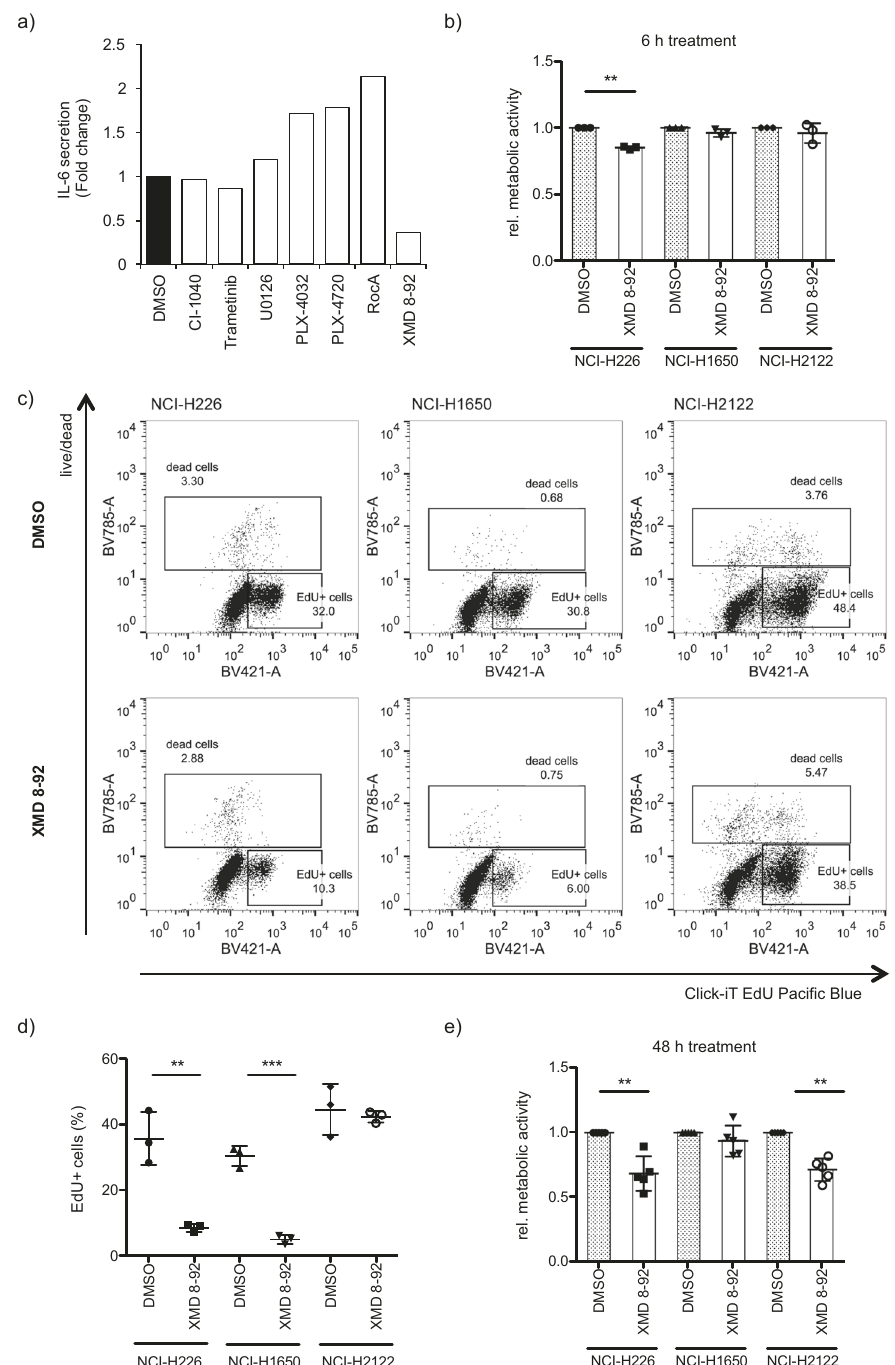
Fig. 4 ERK5 inhibition negatively in fl uences viability of cancer cells. a NCI-H226 cells were treated for 4 h with a panel of MAPK pathway inhibitors including the MEK inhibitors CI-1040 (2 µM), Trametinib (2 µM) and U0126 (2 µM), the RAF inhibitors PLX-4032 (2 µM), PLX-4720 (2 µM) and RocA (400 nM) and the ERK5 inhibitor XMD 8-92 (2 µM). The medium was replaced by a fresh inhibitor-containing medium and after another 4 h of incubation, the supernatant was harvested. IL-6 secretion was determined by ELISA ( n = 1). b Metabolic activity of the cancer cell lines NCI-H226, NCI-H1650, and NCI-H2122 was measured by MTT assay after treating cells for 6 h with DMSO or XMD 8-92 (10 µM) (mean fold change ± SD; n = 3). c NCI-H226, NCI-H1650, and NCI-H2122 were treated for 24 h with DMSO or XMD 8-92 and EdU assay